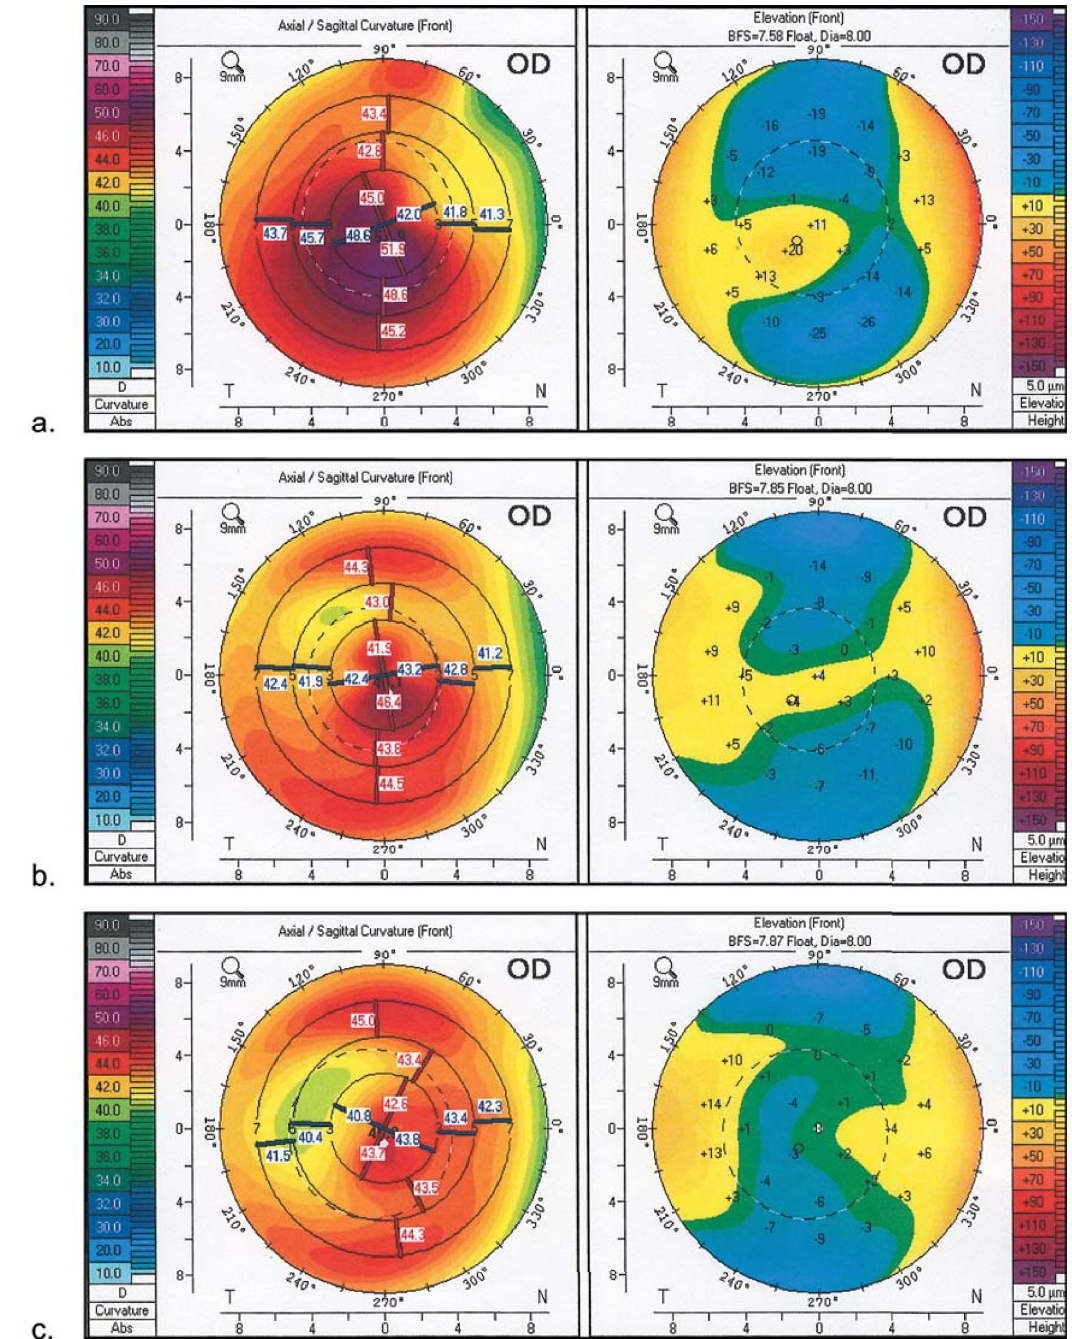
Fig 3. Pentacam sagittal curvature (front) and elevation (front) maps in patient from ICRS+CXL+TG-PRK group : a. initial keratometric maps; b. keratometric maps after ICRS+CXL; c. keratometric maps after ICRS+CXL+TG-PRK. ICRS = intrastromal corneal ring segments; CXL = corneal collagen cross-linking; TG-PRK = topography-guided photorefractive keratectomy.